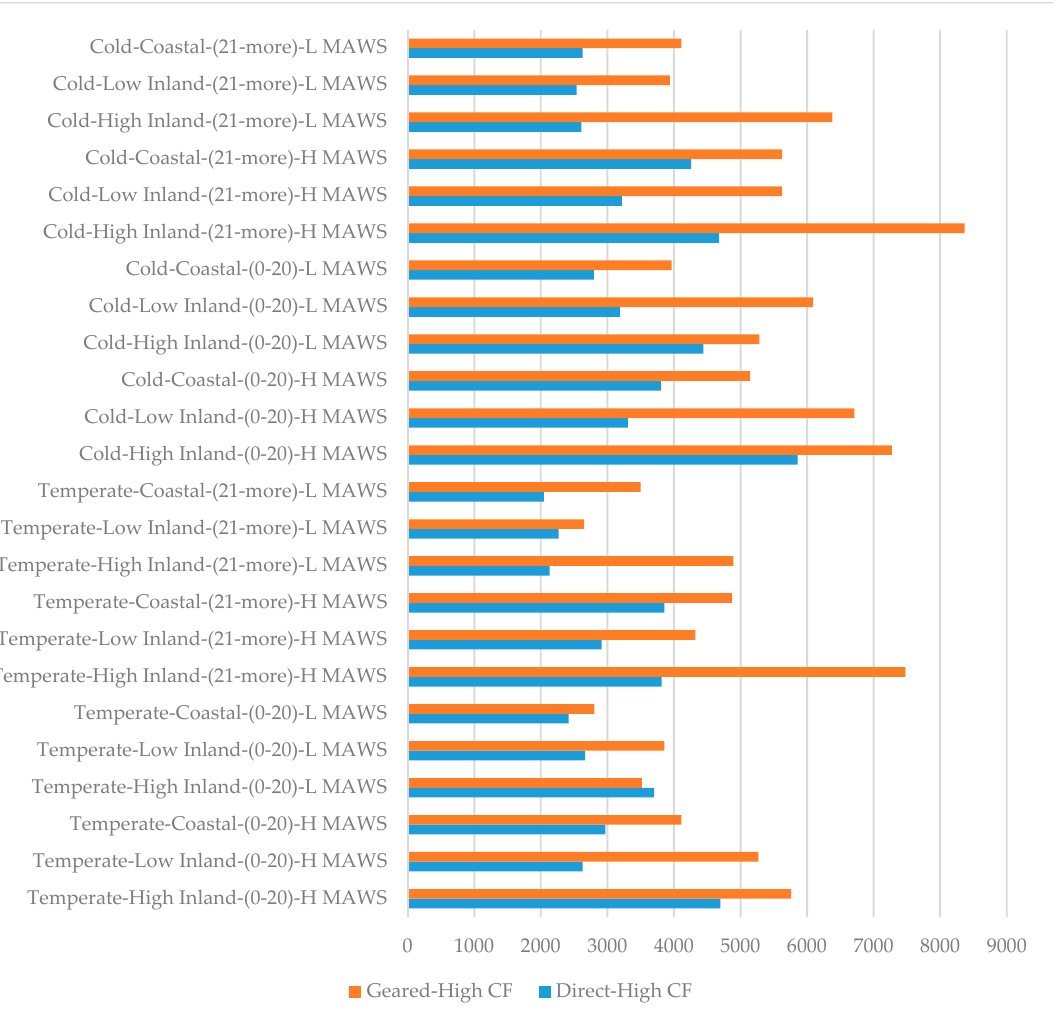
Figure 7. Predicted cost of failures at locations with high capacity factor.